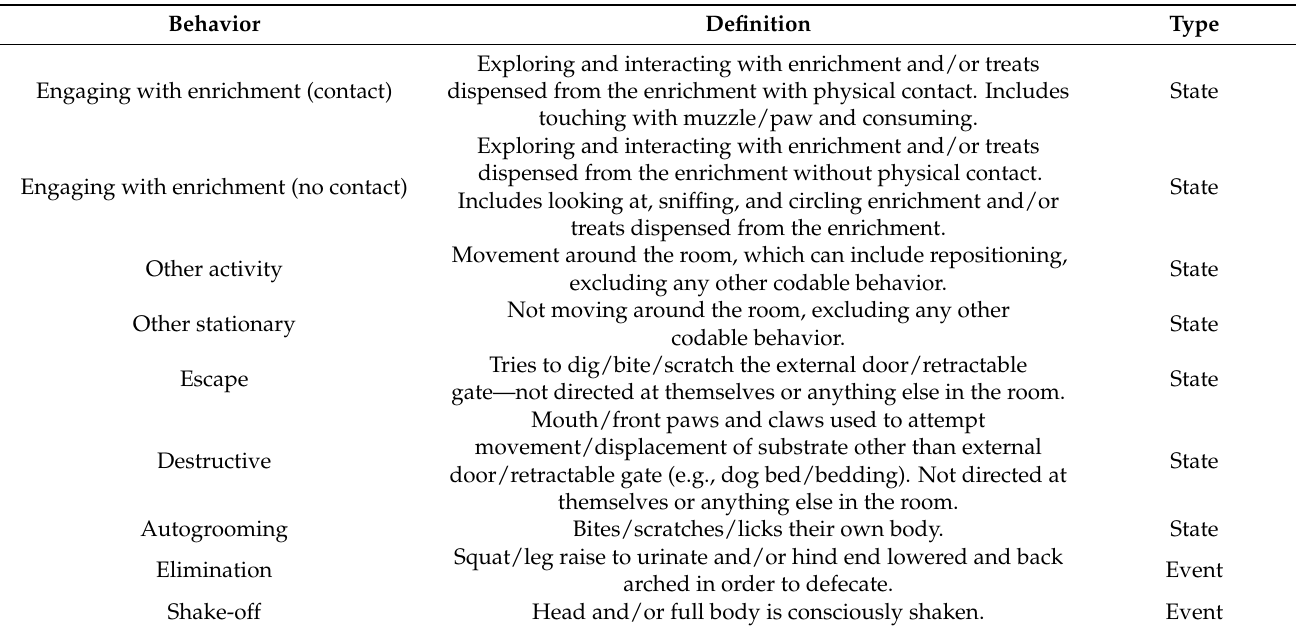
Table 1. Ethogram used for the coding of behavioral measures from